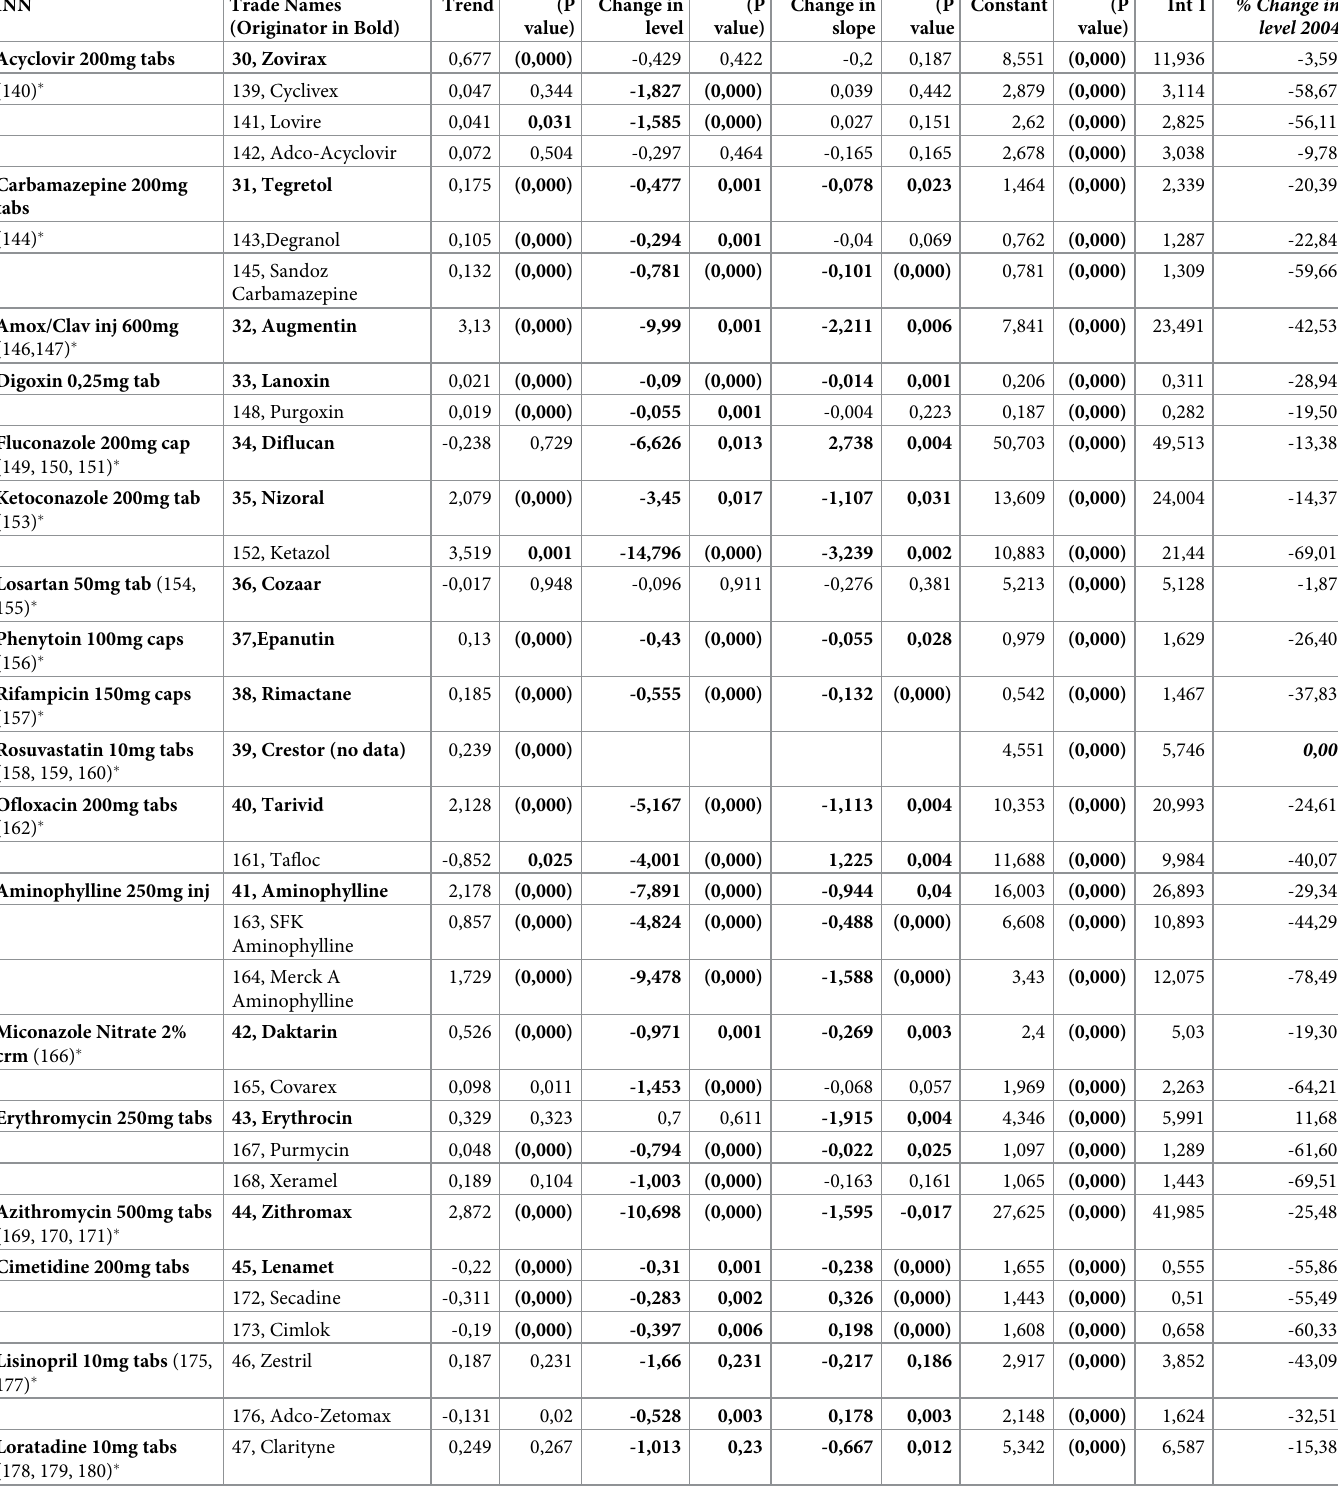
Table 3. Supplementary list interrupted time-series analysis for originator and generic molecules using pricing data from 1999 to 2014 with 2004 as the interrup- tion in the series. statistically significant values (P < 0,05).